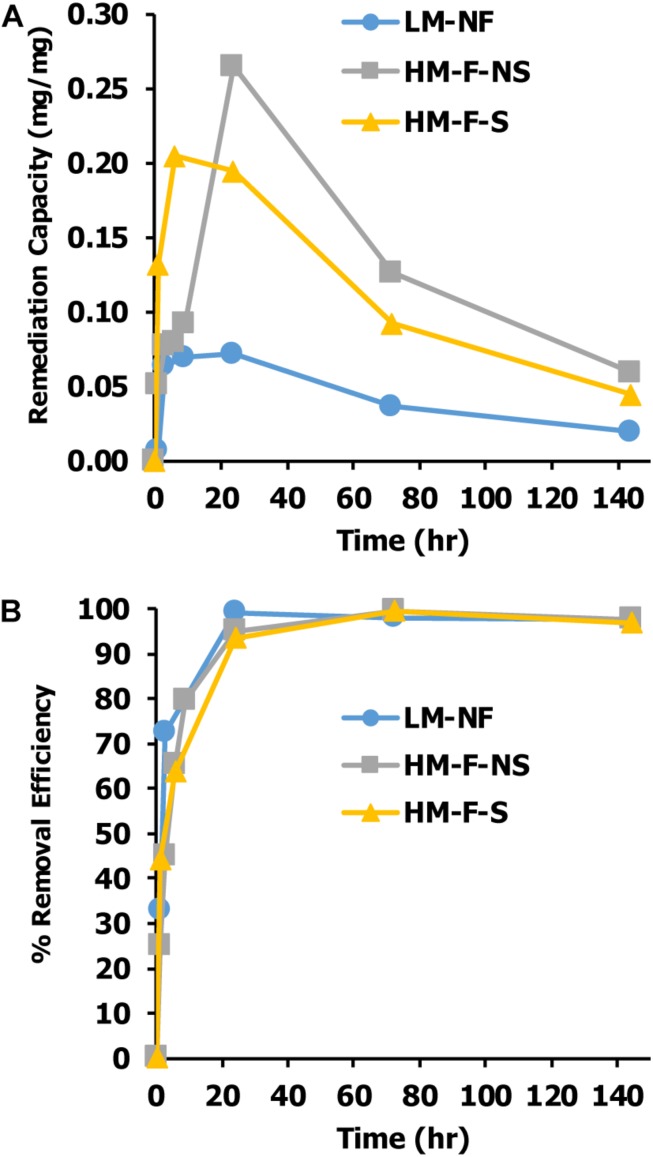
Effect of contact time on (A) Mn remediation capacity of Pediastrum duplex AARLG060 and (B) percent of Mn remediate efficiency. LM-NF, low Mn non-filter; HM-F-NS, high Mn filter non-sterile; and HM-F-S, high Mn filter sterile.